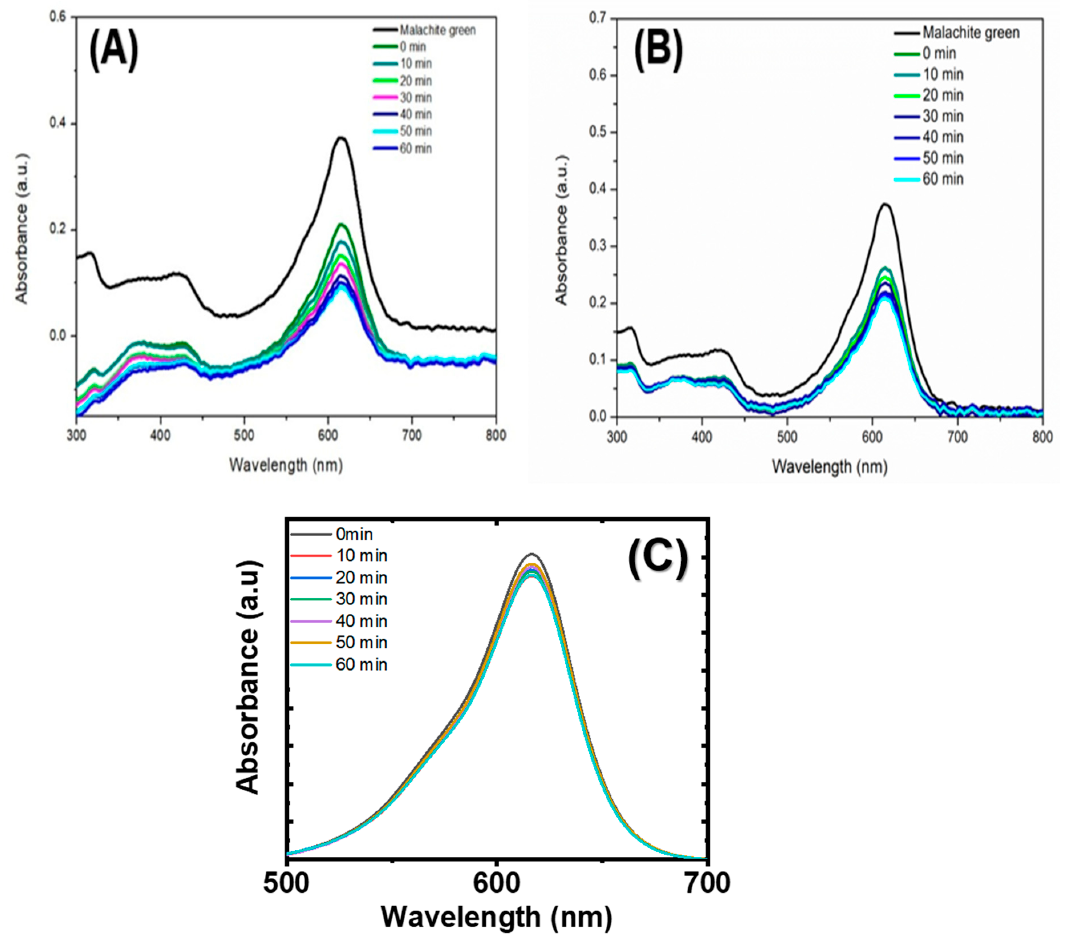
Figure 9. The absorption spectra of the malachite green solution using CuFe 2 O 4 at: ( A ) 400 °C, ( B ) 1100°C, and ( C ) photolysis.